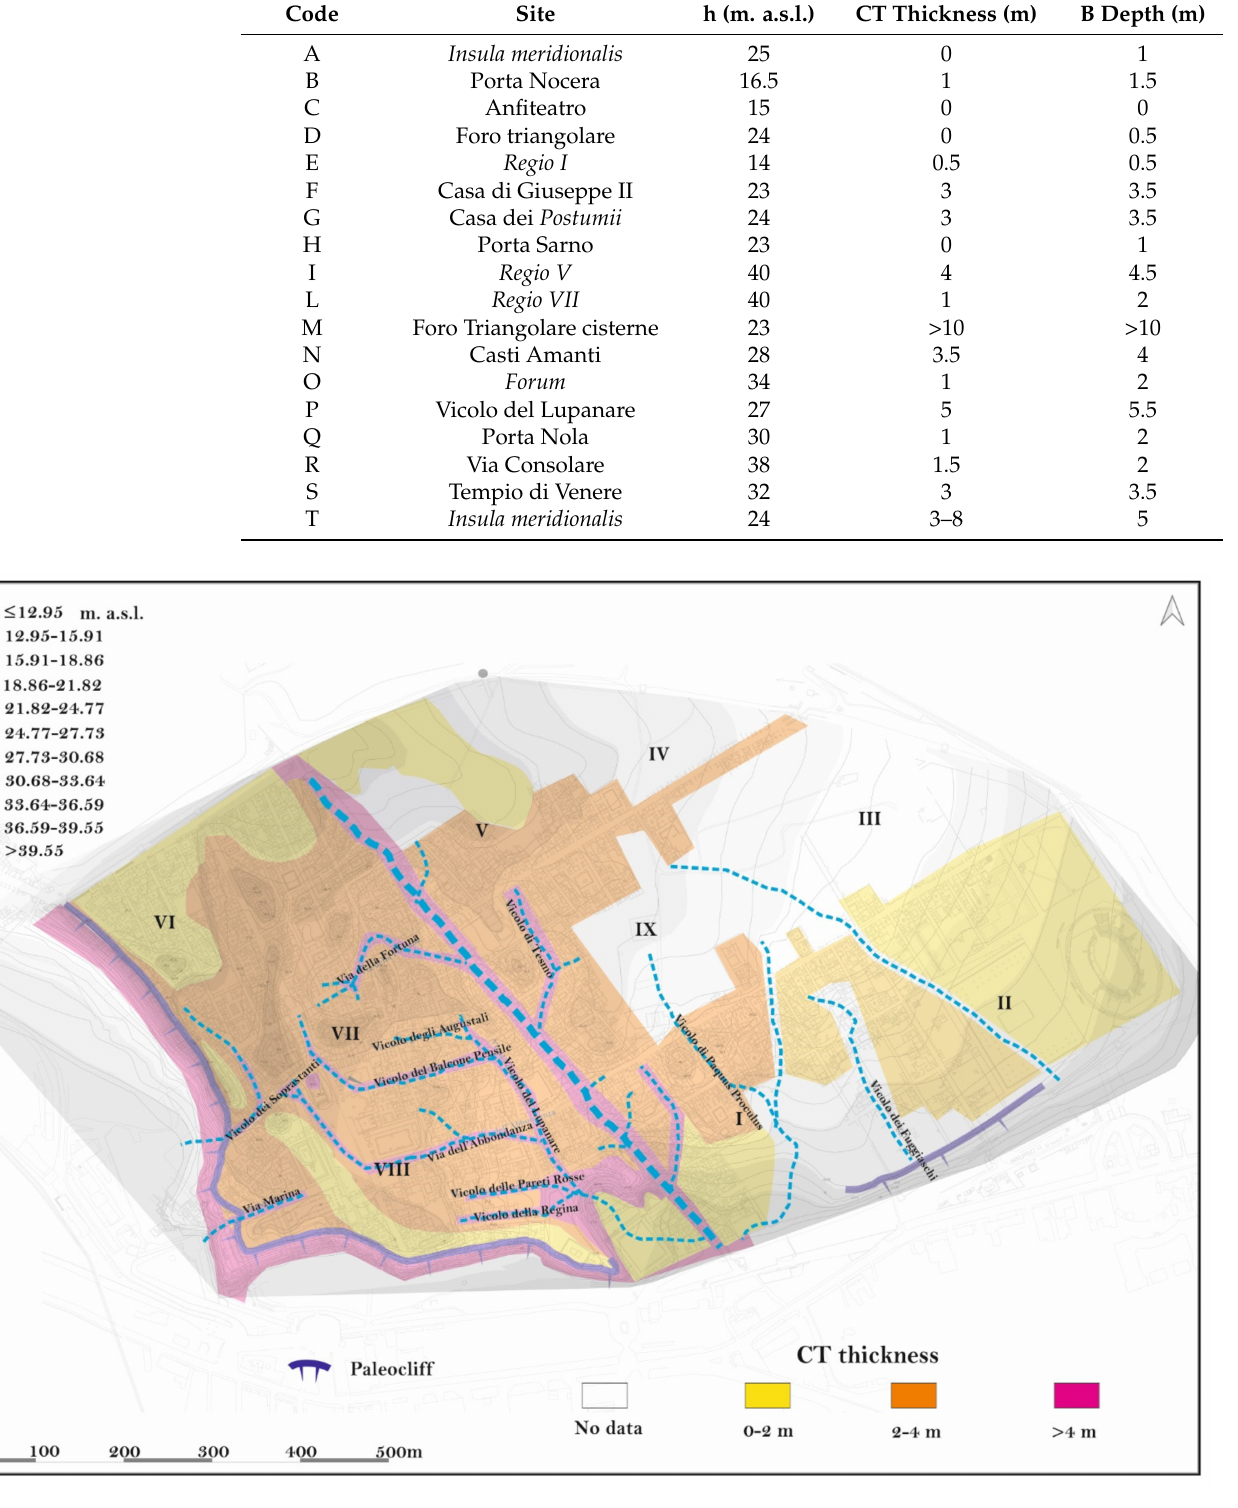
Figure 8. Geological zonation (SGM) and CT thickness distribution. The Regiones (I–IX) are